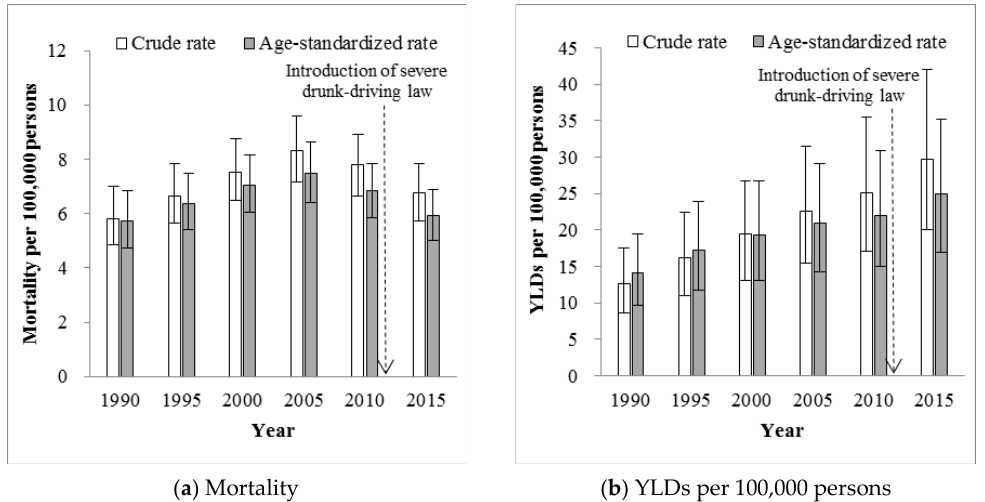
Figure 1. Crude and age-standardized mortality and years lived with disabilities (YLDs) per 100,000 persons from road traffic crashes attributed to alcohol use in China based on Global Burden of Disease (GBD) 2015 update, 1990–2015. China implemented more severe penalties for drunk driving in 2011. Error bars denote 95% uncertainty intervals of the estimates.